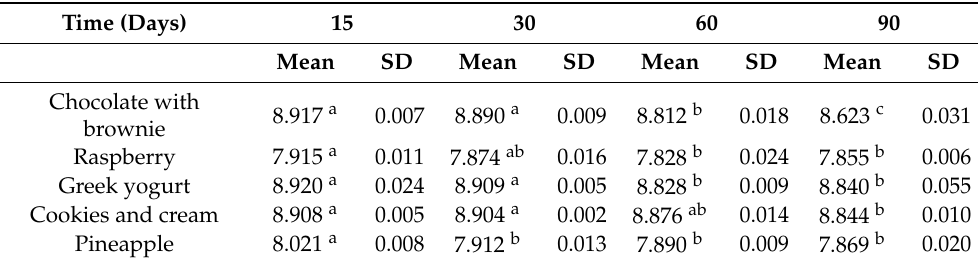
Table 2. In vitro anti- H. pylori activity of the probiotic strain L. fermentum UCO-979C in the different ice cream bases at 90 days of storage at − 18 °C.